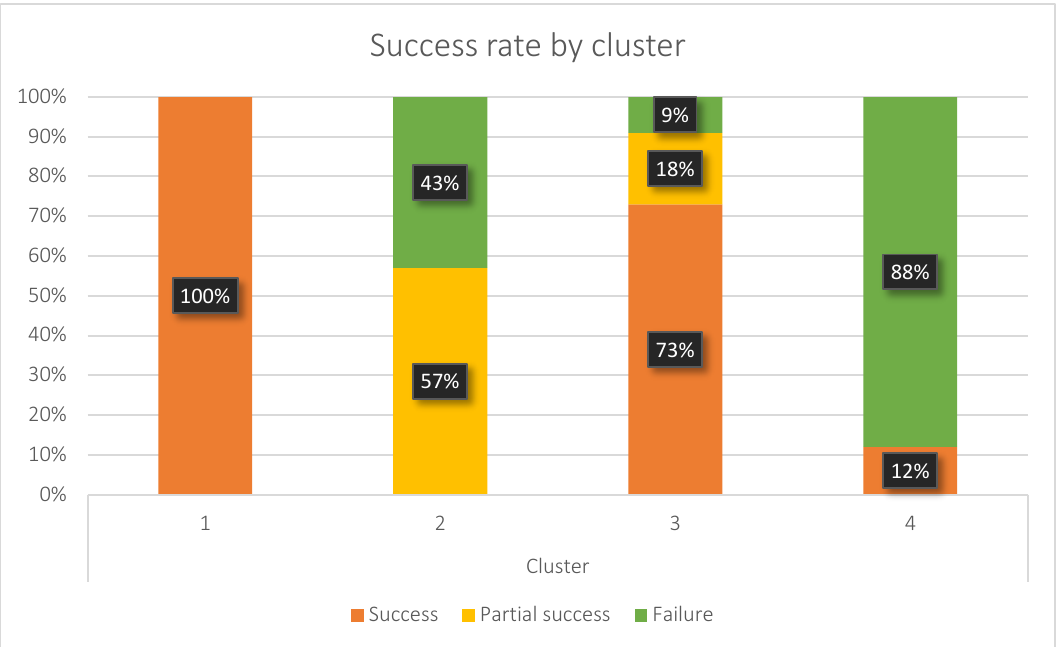
Figure 8. Participants’ overall valence, arousal and cognitive engagement during the experiment.